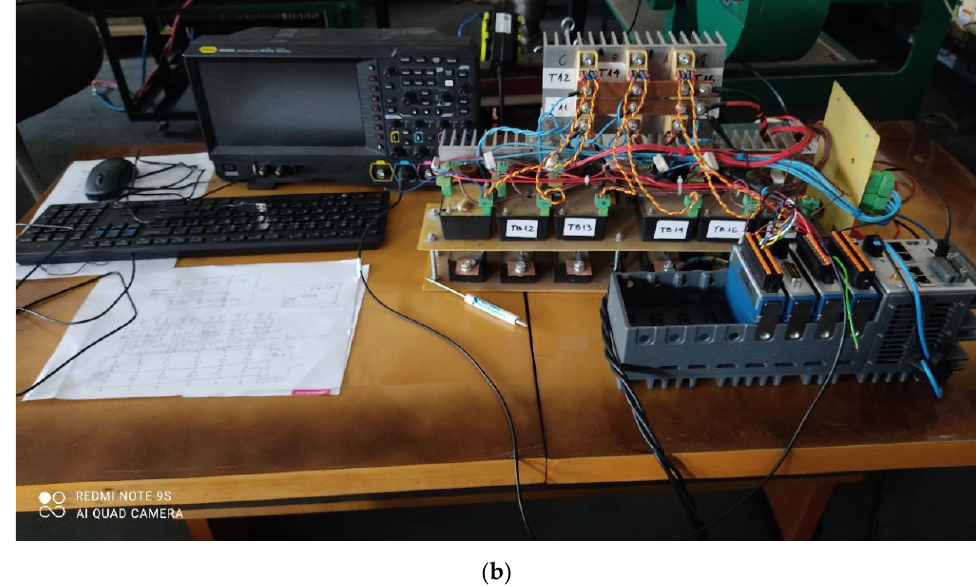
Figure 4. ( a ) Diagram of the 6T rectifier bridge used in simulations. Phase-to-phase input voltages v ab , v bc , v ca are variable amplitude and frequency trapezoidal voltages from the BLDC mogen. ( b ) Photo of the prototype 6T rectifier setup.